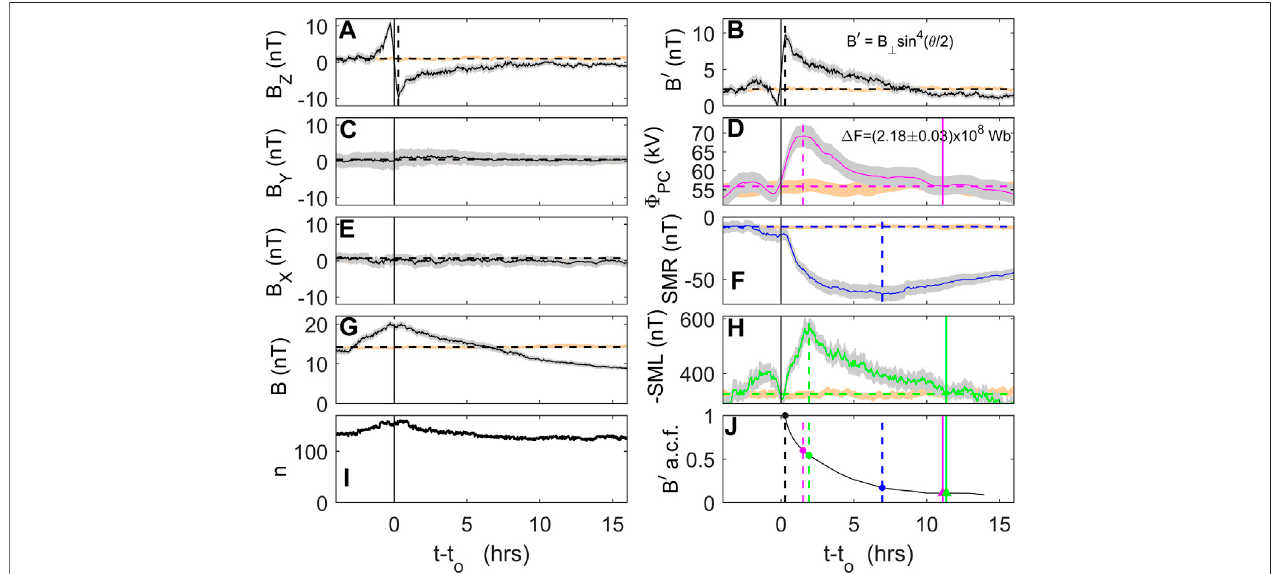
FIGURE6 | Superposed epoch study of responses tosouthward turnings in the IMF. A total of160 southward turning events (at time t o ) were identi fi ed in the data for1996 – 2019(inclusive) fromtimeswhen30-minrunningmeansof1-minvaluesofthenorthwardIMFcomponent, B Z ,turnedfrompositivetonegativewithadecrease in successive values exceeding 0.75 nT. The line in each panel gives the mean of 1-min values at epoch time ( t − t o ) and the gray area around it is plus and minus one standard error in the mean. The left hand panels are for the IMF and parts (D – J) of the right hand panels are about the magnetospheric response. From top to bottom thelefthandpanels arefor: (A) theIMF B Z component; (C) theIMF B Y component; (E) theIMF B X component and (G) theIMF magnitude, B .Panel (I) showsthe number of samples n at each ( t − t o ). The top right-hand panel, (B) , is for the IMF factor B ′ = B ⊥ sin 4 ( θ /2) where (where B ⊥ = ( B Y2 + B Z2 ) 1/2 , and θ is the IMF clock angle de fi ned as θ = arctan(| B Y |/ B Z ). Panel (D) is for the transpolar voltage Φ PC ; (F) the SMR geomagnetic index; and (H) the SML geomagnetic index. The bottom panel, (J) , showsthea.c.fof B ′ =B ⊥ sin 4 ( θ /2)forthesubsetofdatacontributingtothesuperposedepochevents,startingfromthetimeofpeak B ′ toillustratetheprobabilitythatthe IMF factor has changed from its peak value after the southward turning. Vertical dashed lines mark the epoch times at which the mean disturbance peaks and vertical solid colored lines mark the times the parameter returns to its pre-event level (only shown for Φ PC and SML because this is greater than 1 day for SMR and so off scale). Theseverticallinesarerepeatedinpart (J) .Forallsuperposedepochpanels,themeanobservedoverapre-eventcalibrationperiodof − 4 ≤ ( t − t o ) < − 2 hisshownbythe horizontalline.Theorangebandsisthesameasthegreyones,butfromarandomeventtimeselectionprocedurerepeated500timesandthenaveragedusingthesame numberofeventepochtimes.Thishasbeennormalizedbymultiplyingbytheratioofthecalibrationperiod meansfortheobservedandtherandomly-selectedeventsso that the magnitude of the observed event response can be